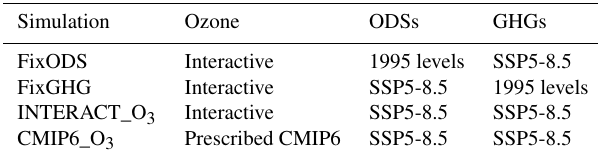
Table 1. Simulations analyzed in this